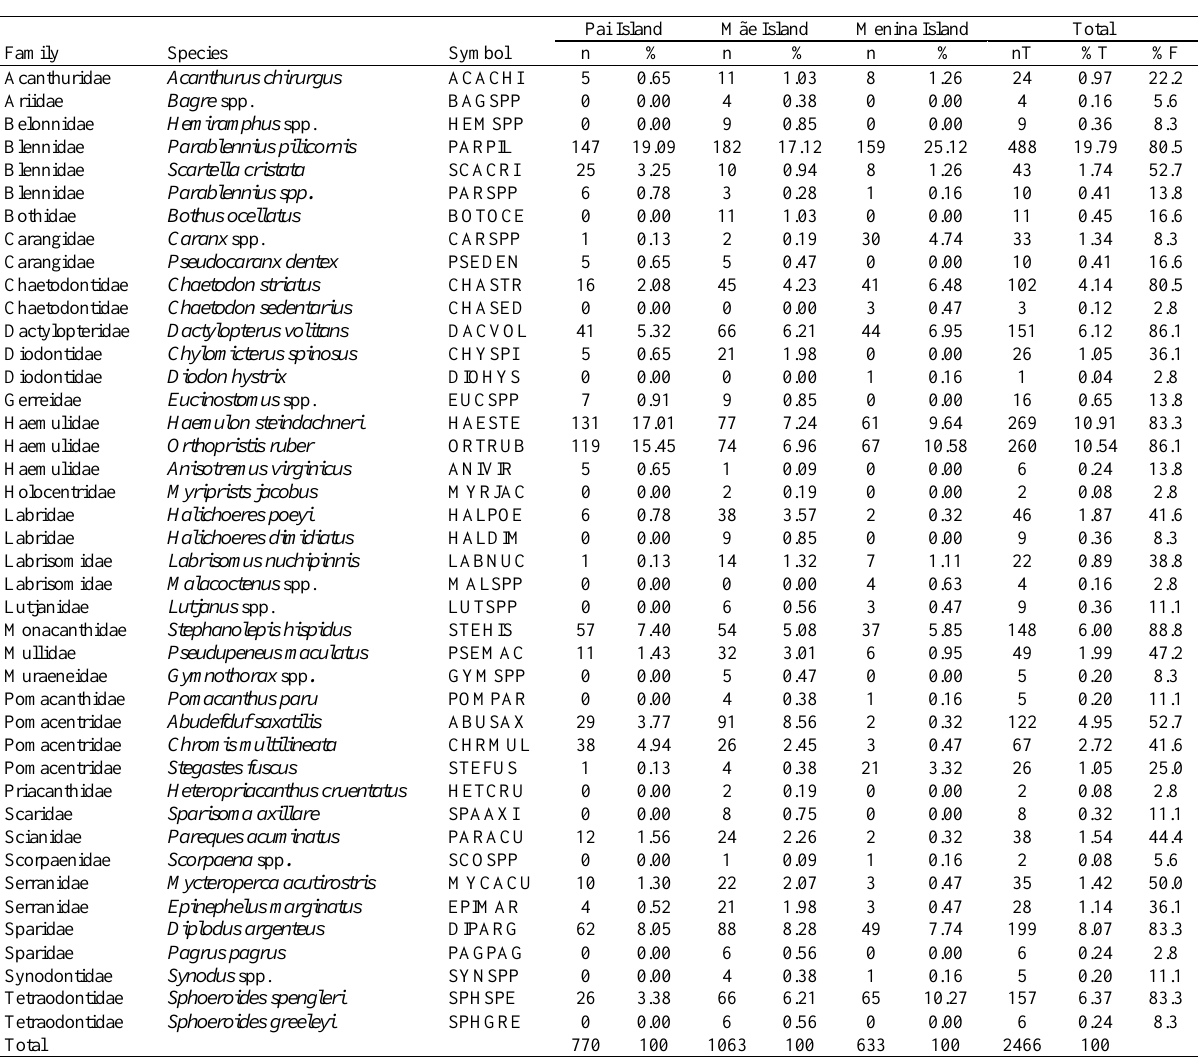
Table 1. Fish families, species, symbols, number of individuals (n) and relative abundance (%) at each site (Pai, Mãe, and Menina Islands) and pooled for all sites (Total).